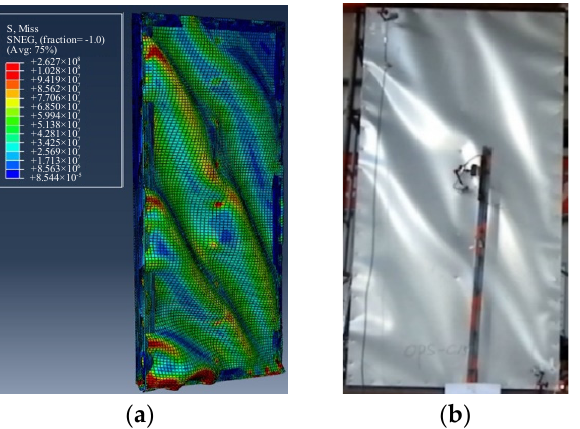
Figure 19. Comparison of failure modes between the FEA and the test results for specimen FW − 2 (W − 2): ( a ) FEA result, ( b ) test result.